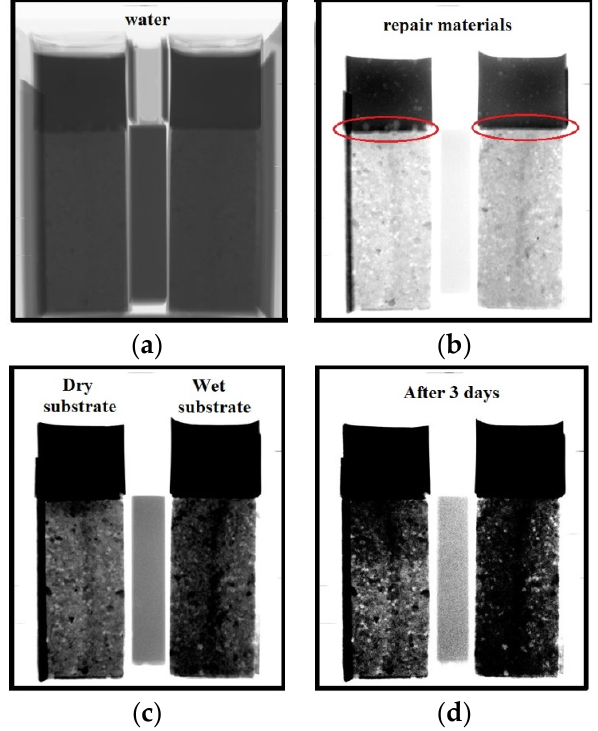
Figure 8. X ‐ ray measurements on repair systems (w/c = 0.3, DS, S3 and w/c = 0.3, WS, S3): ( a ) Reference image; ( b ) Chosen GSV range with the emphasis on the repair material; ( c ) Chosen GSV range with the emphasis on the mortar substrate; and ( d ) Image after 3 d of sealed curing.